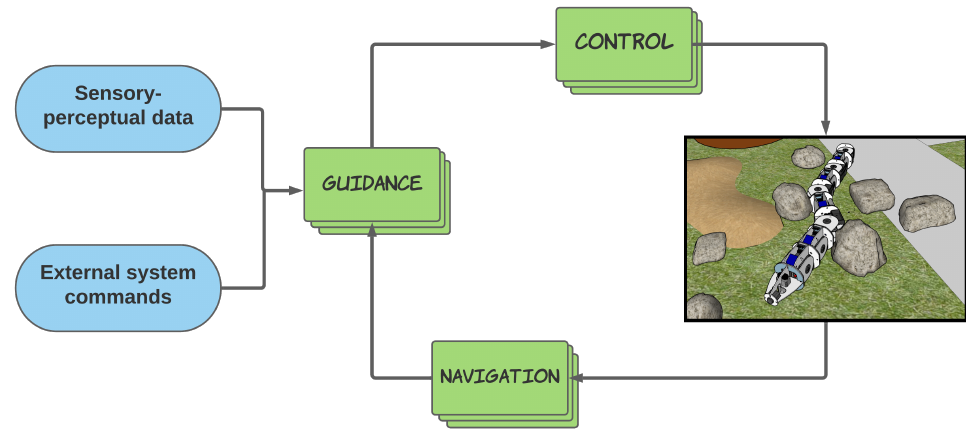
Figure 5. A generalised guidance, navigation, and control architecture for snake robot